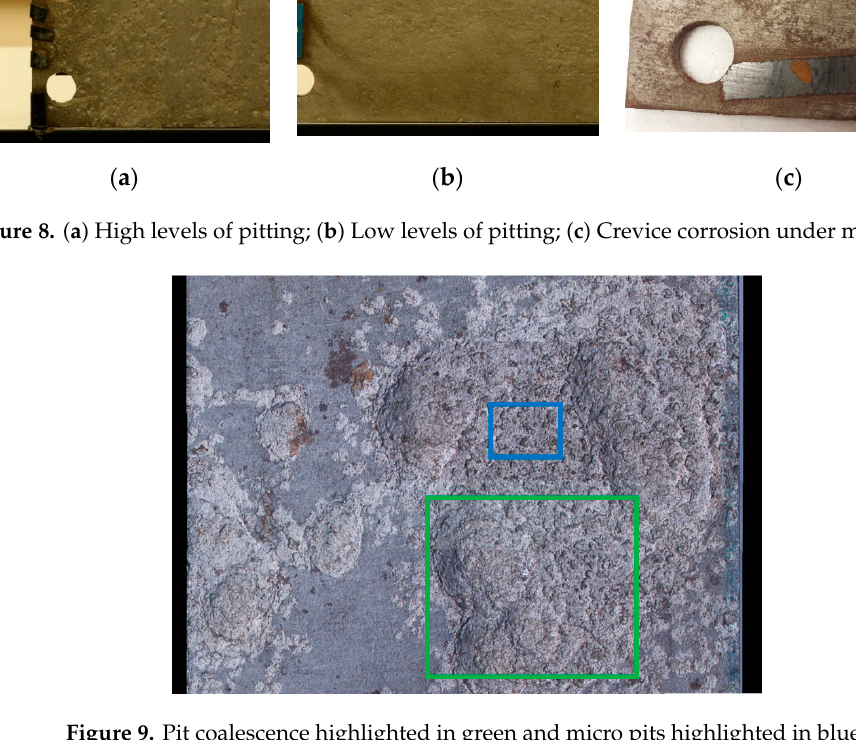
Figure 9. Pit coalescence highlighted in green and micro pits highlighted in blue.